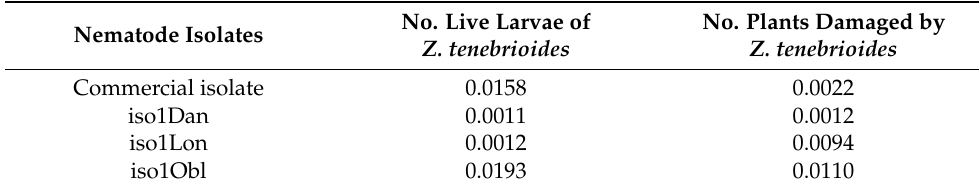
Table 3. p -Values in the Shapiro–Wilk test.